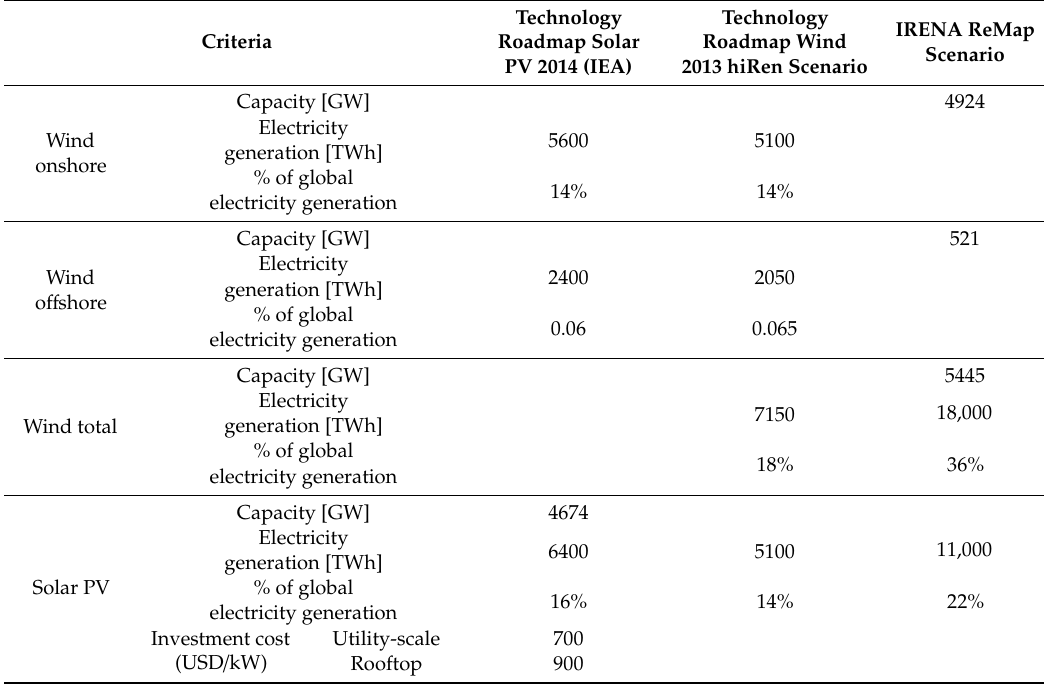
Table 1. World capacity, electricity generation and investment costs of solar PV and wind energy globally in year 2050 (sources of data: [41,44,48]).